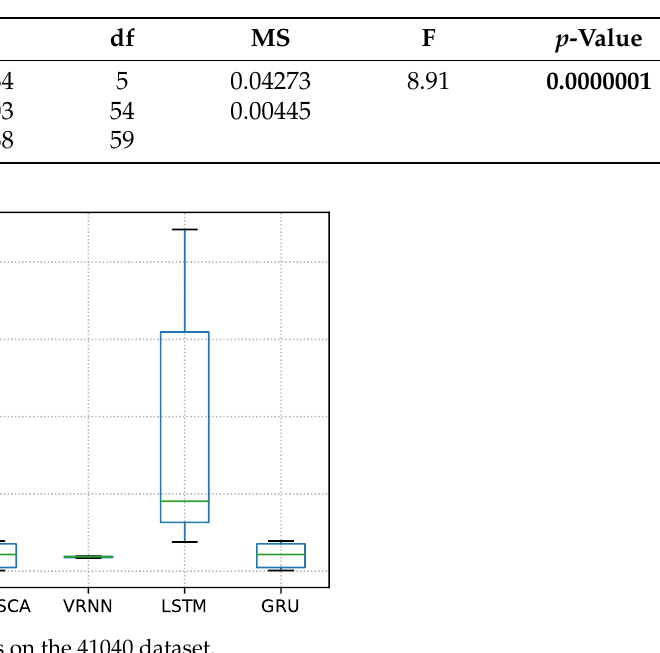
Figure 15. Boxplot differences on the 41010 dataset. Table 15. ANOVA table results on the dataset 41040.